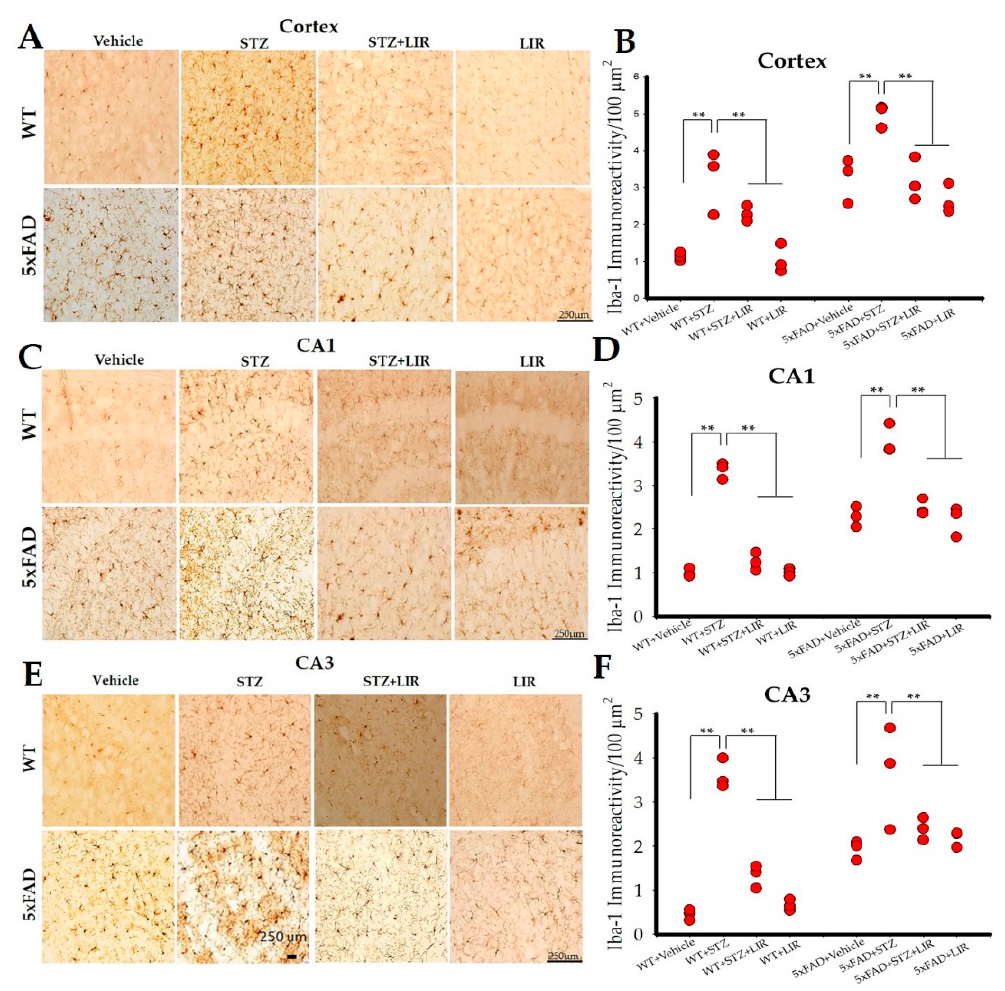
Figure 3. Microglial activation in the cortical, and hippocampal CA1 and CA3 regions of WT and 5xFAD mice. Following 30 days of LIR injections, WT and 5xFAD mice ( n = 3 from each group) were sacrificed and perfused transcardially with 4% paraformaldehyde. The brains were sectioned at 30 µm on a cryostat and the sections were immunolabelled with Iba-1 antibody. ( A , C , E ): Photomicrographs showing immunoreactive (IR) microglia (brown) in the cortical, CA1 and CA3 regions of hippocampus in the WT and 5xFAD mice. ( B , D , F ): Histograms representing Iba-1-IR/100 µm 2 in all the groups of the cortical, CA1 and CA3 hippocampal regions of WT and 5xFAD mice. Data from three different mice in each group were expressed as mean ± SEM; Scale bar is 250 µm for all images. ** p < 0.01.